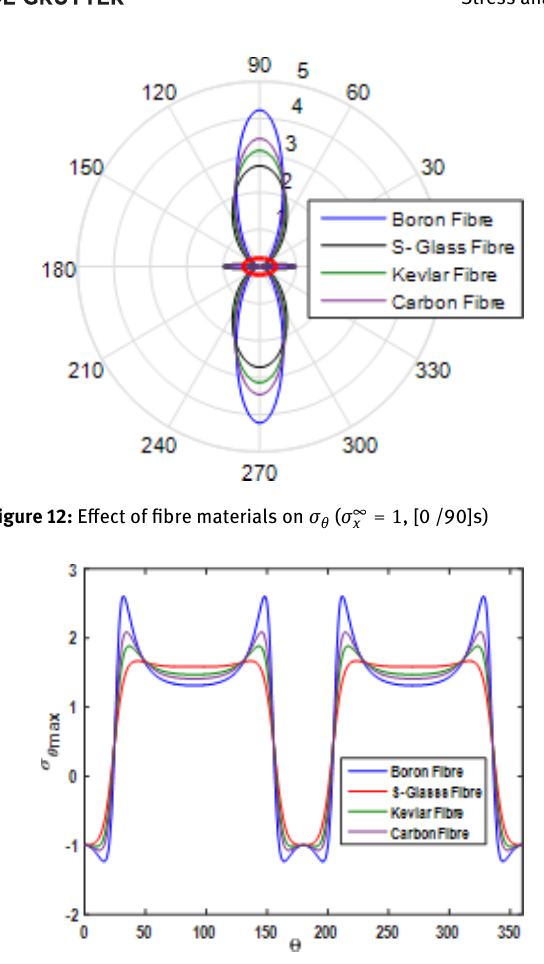
Figure 13: Effect of fibre materials on σ ∞